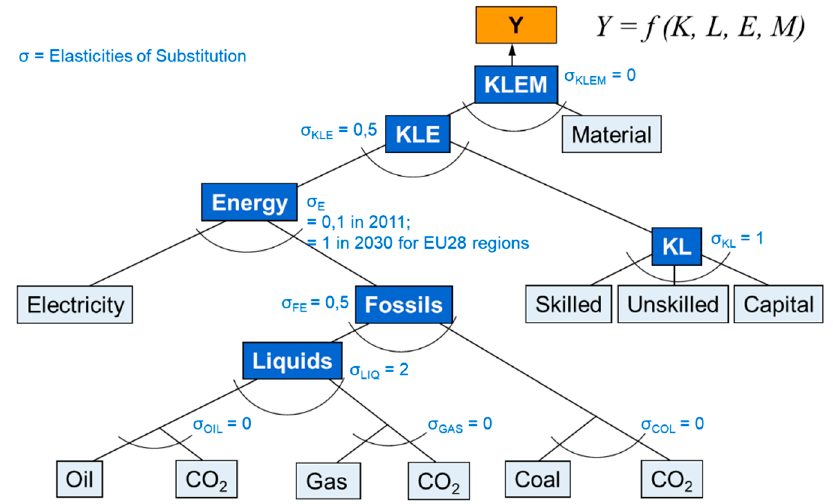
Figure A1. Nesting of NEWAGE CES production functions (given values for elasticities of substitu- tion apply for 19 out of the 23 production sectors).